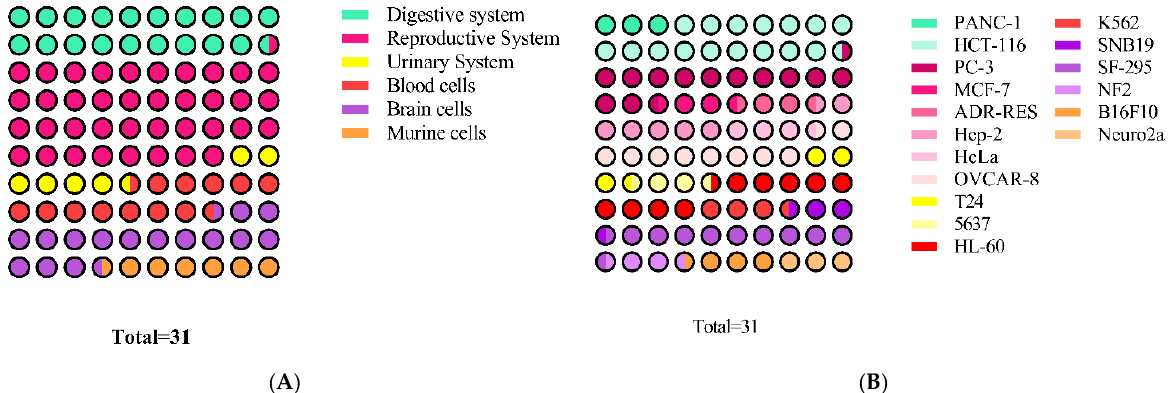
Figure 6. Variety of cell lines inhibited by Brazilian propolis. ( A ) The cell lines are divided into systems, and ( B ) into cell lines. All cell lines are shown in shades of the color of the system they belong. Sixteen papers were used. Brazilian propolis anticancer activity: 5637 (human bladder carcinoma), B16F10 (murine), PC3 (prostate adenocarcinoma), PANC-1, MCF-7, ADR-RES, Hep-2 (human laryngeal epidermoid carcinoma cells), HeLa (human cervical adenocarcinoma) cancer cell lines, HL-60 (leukemia), K562 (erythroleukemia), SNB19 (glioblastoma), SF-295 (glioblastoma-human), OVCAR-8 (breast), HCT- 116 (colon), Neuro2a, NF2 (tumor in mice), skin carcinogenesis/papilloma, T24, proteinuria, inhibiting TNF- α , stimulating IL-10 production [26,50,64,76,123,125–136].